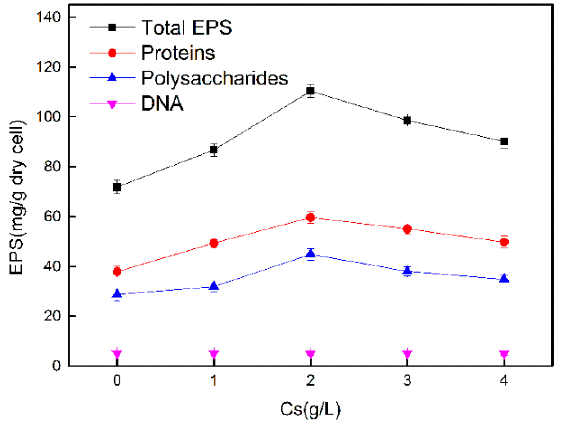
Figure 2. EPS production by Synechococcus PCC7002 under different concentrations of Cs(I).